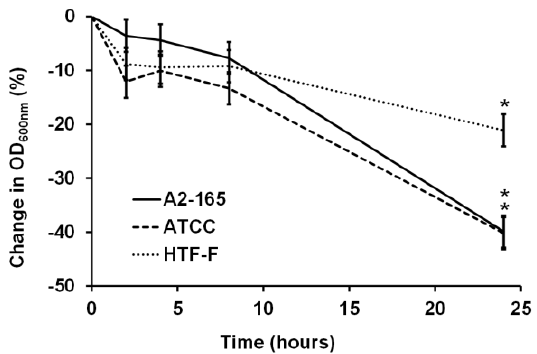
Figure 2. Normalized change in OD 600nm (%) of the three F. prausnitzii strains in an anaerobic cell culture medium. The three F. prausnitzii strains (A2-165, ATCC 27768, and HTF-F) in stationary phase were resuspended in anaerobic M199 TEER, incubated at 37 °C, and the OD 600nm was measured over 24 h. The graph shows the mean values (±SEM; n = 3) after normalizing by the OD 600nm at time 0 h for each of the three F. prausnitzii strains over 24 h. * Change in OD 600nm different compared to previous time point for the same strain ( p < 0.05).